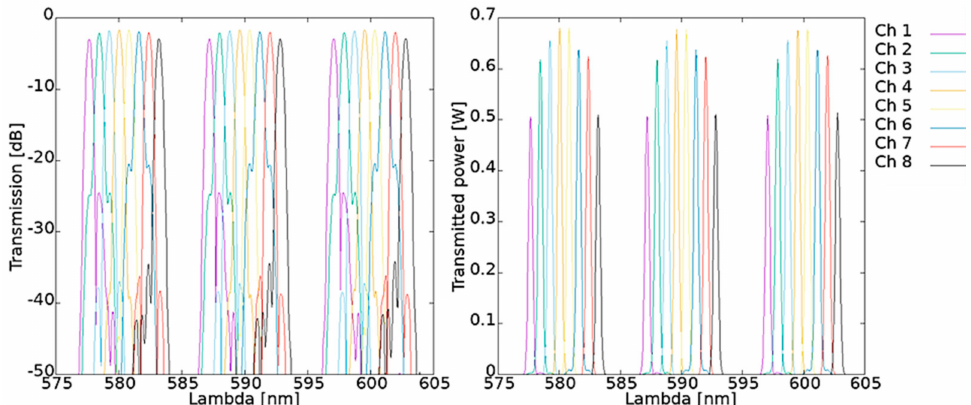
Figure 7. Simulated output spectra of AWG 100 GHz 1 × 8, λ c = 590